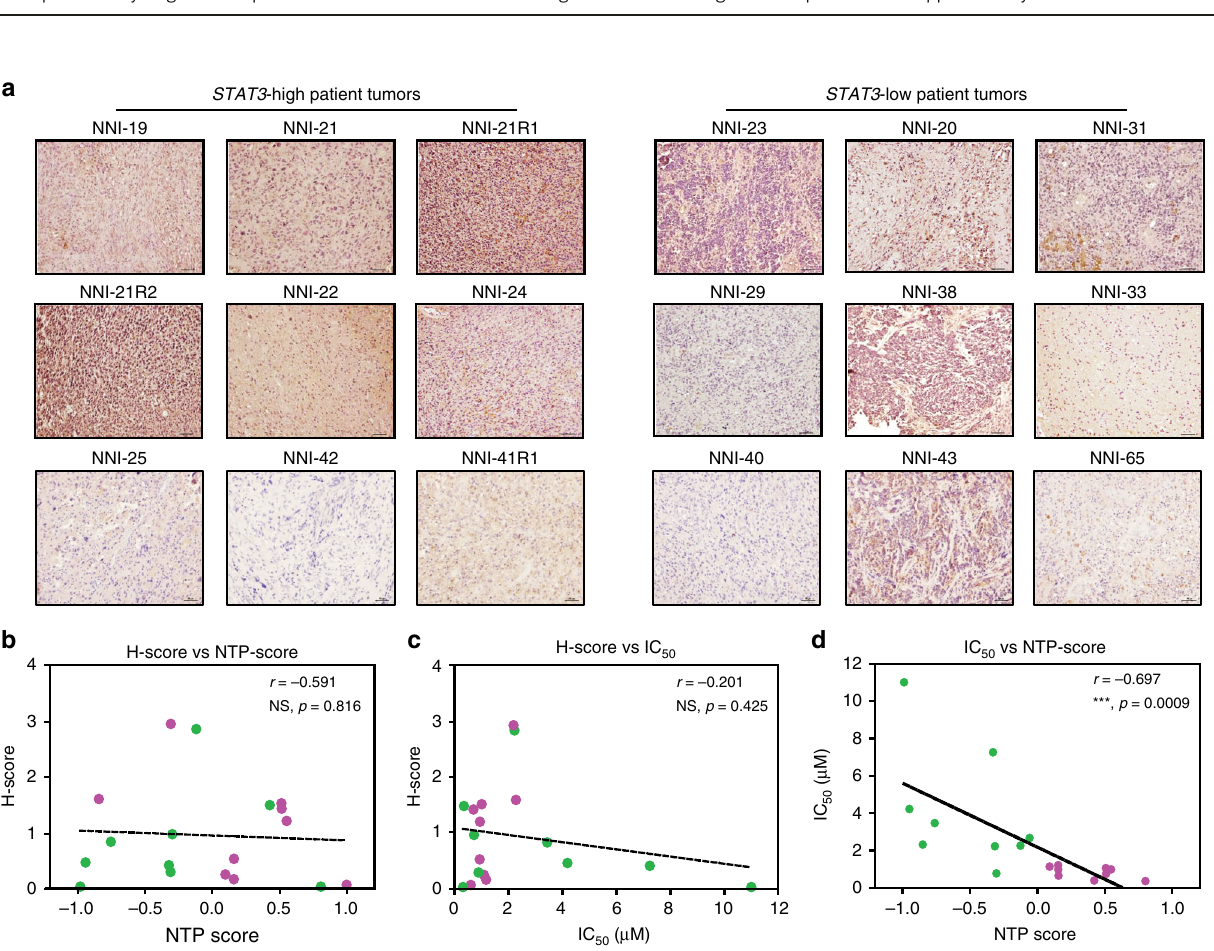
Fig. 6 NNI- STAT3 transcriptomic signature better identi fi es responsive patient cohort. a Immunohistochemical (IHC) staining of NNI patient tumors with phospho-signal transducers and activators of transcription 3 (phospho-STAT3). Representative images are shown, scale bar denotes 50 μ m. Based on IHC staining, glioblastoma patient tumors ( N = 18) were not accurately strati fi ed by their STAT3 status. b – d Using three different analyses, there was no signi fi cant correlation of b H -score versus Nearest Template Prediction (NTP) score derived from NNI- STAT3 signature or c H -score versus IC 50 , while d signi fi cant negative correlation was only established when IC 50 was plotted against the NTP score. *** p < 0.001. This indicates that our STAT3